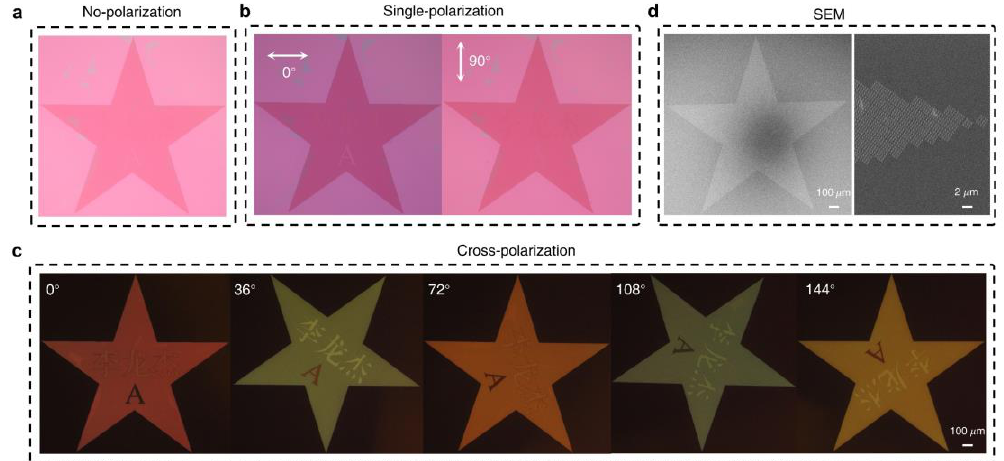
Figure 4. Anti-counterfeiting feature of the embedded chiral metasurfaces. ( a ) Micrograph of a star with encrypted information under no polarization. ( b ) Micrograph of a star with encrypted information under single-polarization (0 degrees or 90 degrees). ( c ) Micrograph of a star with encrypted information under cross-polarization with the sample rotated at an angle of 0, 36, 72, 108, and 144 degrees. ( d ) The top view SEM images of the entire star and one of the corners consist of embedded chiral metasurfaces.